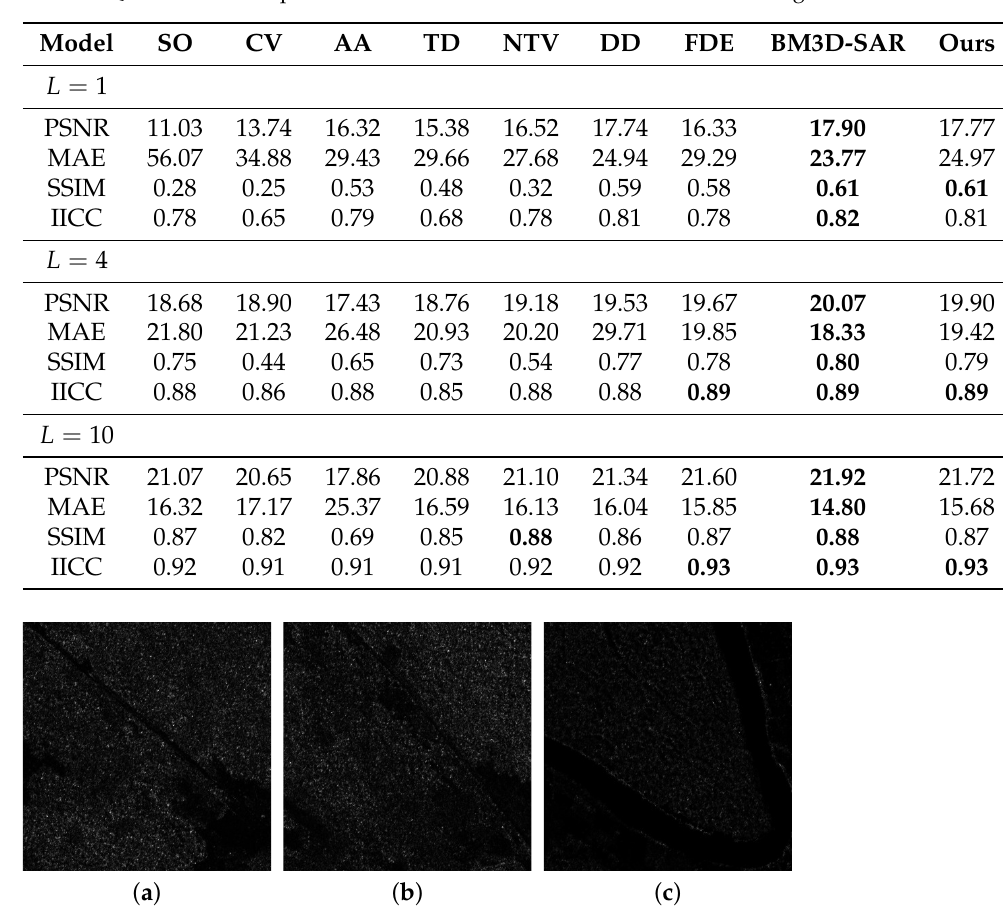
Figure 9. Real SAR images: ( a ) The SAR1 image. ( b ) The SAR2 image. ( c ) The SAR3